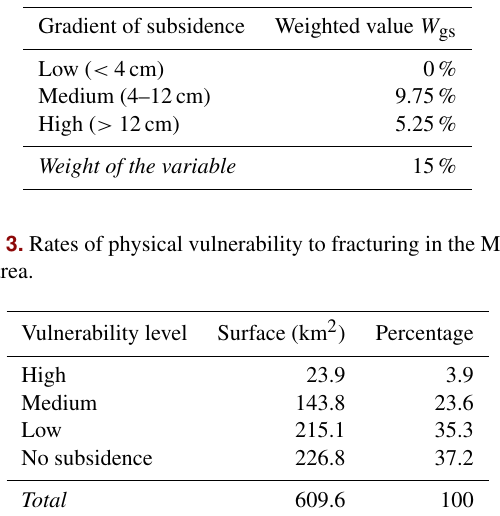
Table 2. Weighted values for the gradient of subsidence ( g s ).